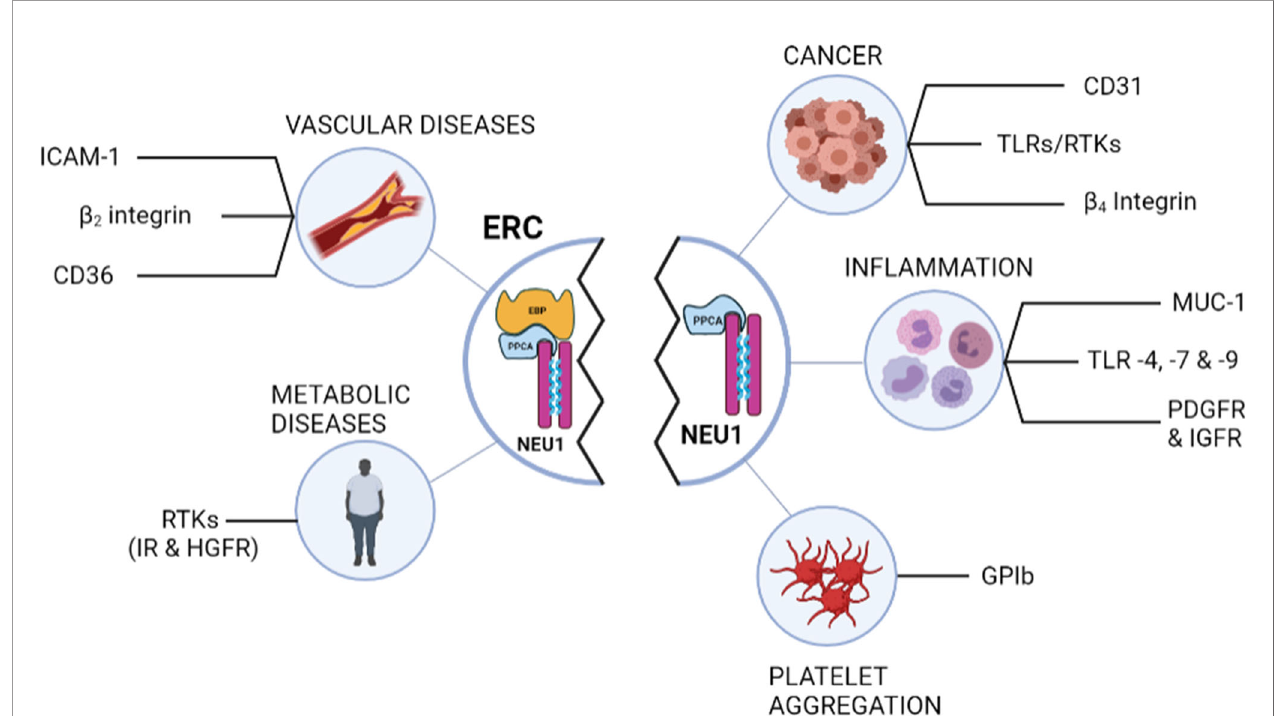
FIGURE 2 | Schematic representation of the membrane glycoproteins regulated by desialylation through NEU1 and potential biological relevance in various diseases. Left panel shows the membrane glycoproteins regulated by desialylation through NEU1 after ERC involvement. Right panel lists the other membrane glycoproteins that have been shown to be desialylated by NEU1. Whether these latter can be modulated by the ERC remains to be evaluated. EBP, elastin-binding protein; ERC, elastin receptor complex; HGFR, hepatic growth factor receptor; ICAM-1, intercellular adhesion molecule- 1; IR, insulin receptor; MUC-1, mucine-1; NEU1, neuraminidase-1; PDGFR, Platelet-derived growth factor receptor; PPCA, protective protein/cathepsin A; IGFR, insulin-like growth factor receptor; RTK, receptor tyrosine kinase; TLR, toll-like receptor